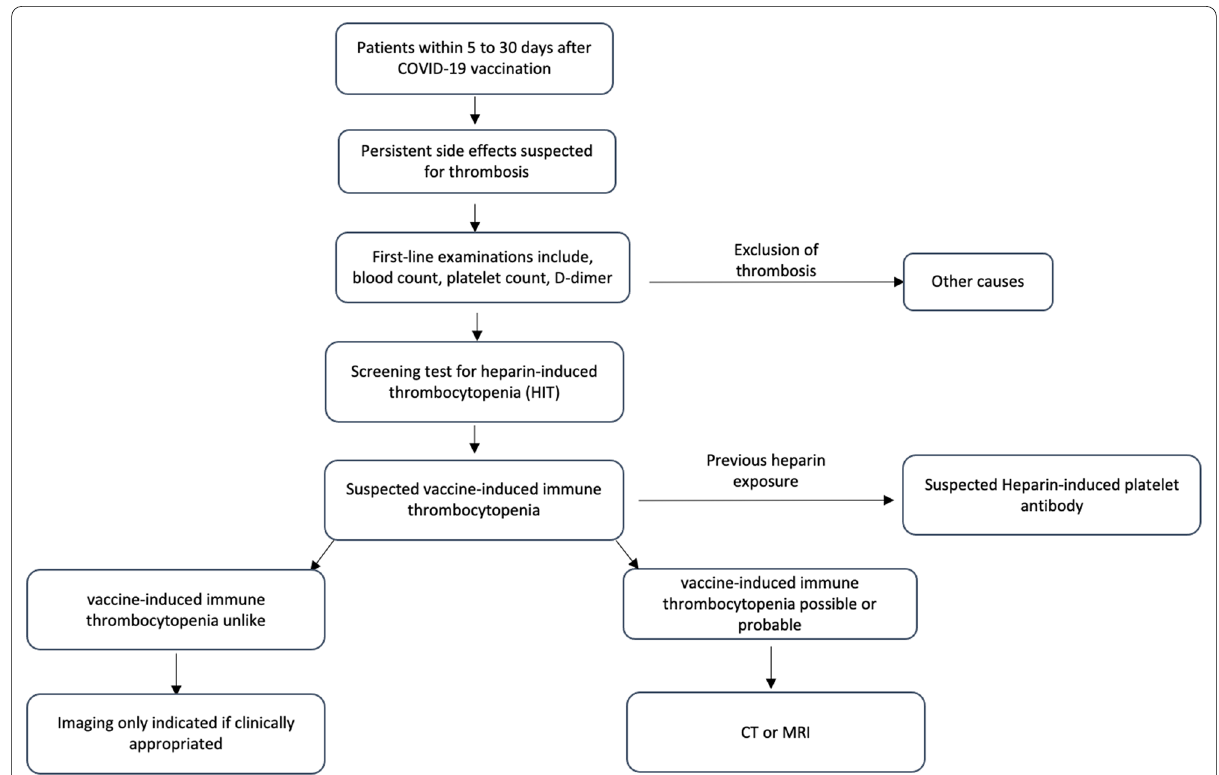
Fig. 7 Diagnostic flowchart for suspected vaccine-induced immune